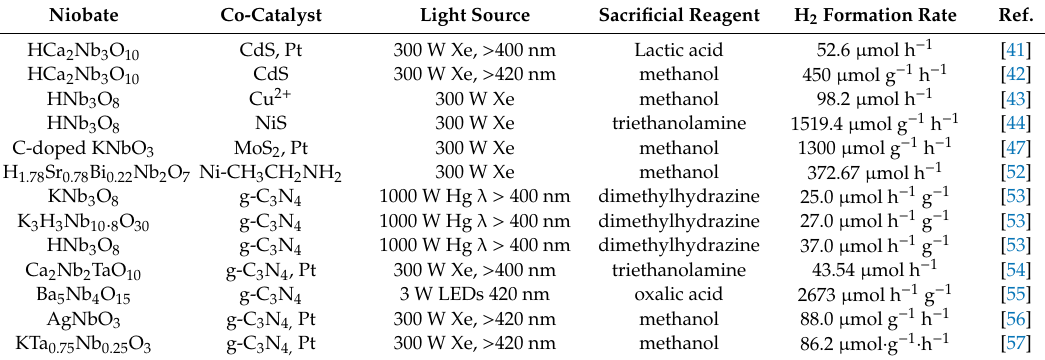
Table 1. Summary of the photocatalytic activity of niobates combined with distinct materials towards H 2 eVolution from aqueous